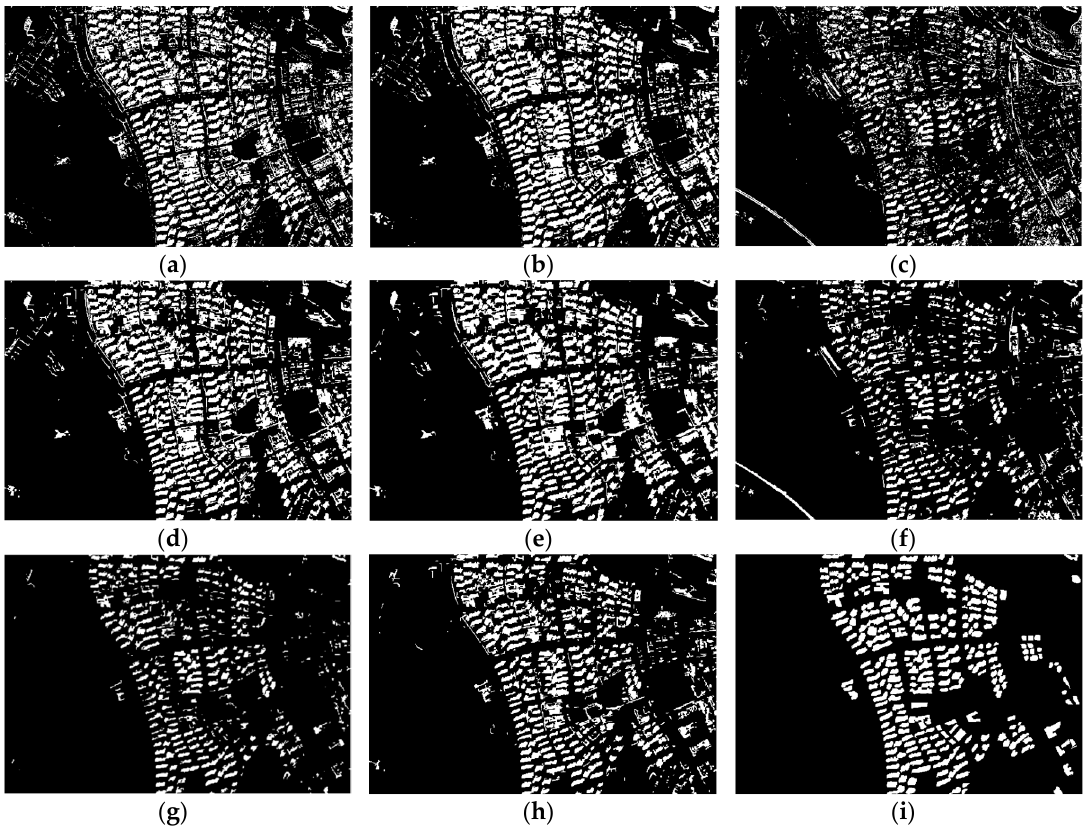
Figure 4. Change detection results of the first subset: ( a ) pixel-based change detection (PBCD) using change vector analysis (CVA), ( b ) PBCD using principal component analysis (PCA), ( c ) PBCD using iteratively reweighted multivariate alteration detection (IRMAD), ( d ) object-based change detection (OBCD) using CVA, ( e ) OBCD using PCA, ( f ) OBCD using IRMAD, ( g ) OBCD using major voting, ( h ) OBCD using the proposed method, and ( i ) the reference map.